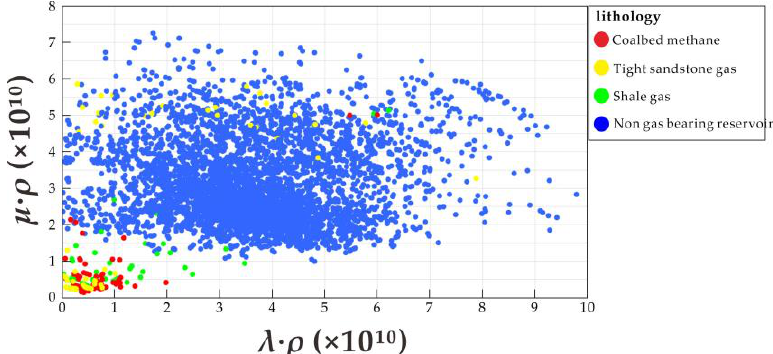
Figure 5. Cross plot of λ · ρ - μ · ρ .